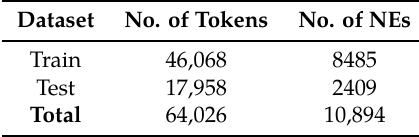
Table 15. NER for South and South-East Asian Languages (NERSSEAL) data set characteristics.